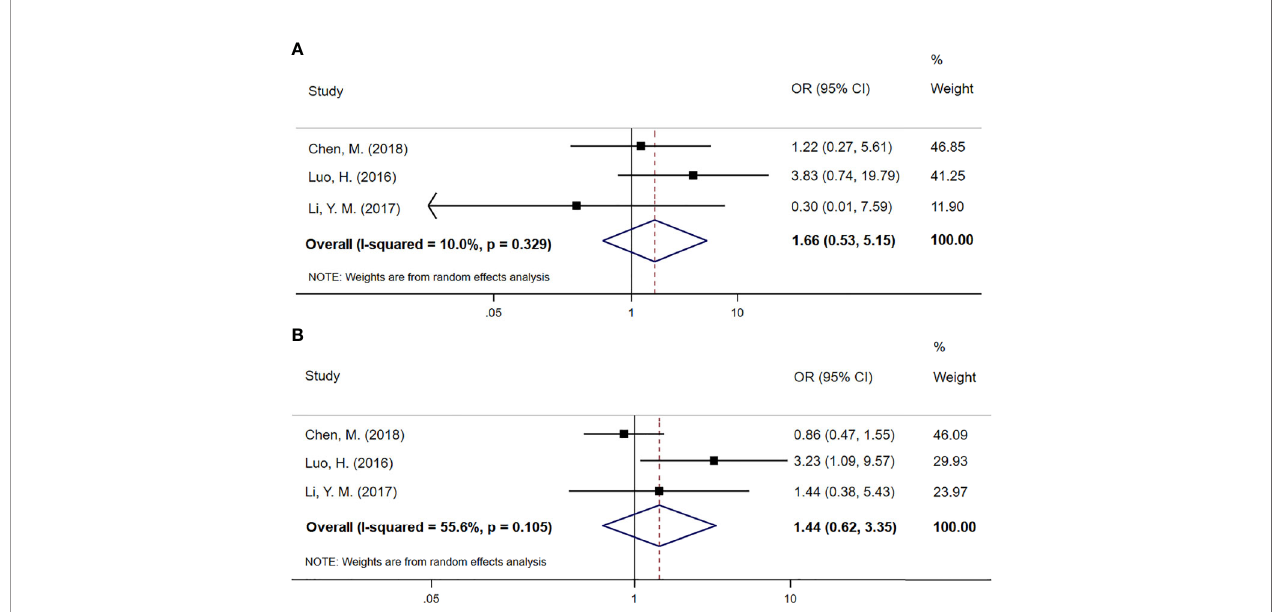
FIGURE 4 | (A) Meta-analysis of the associated ORs of DCR for CCRT – CCT compared with CCRT alone. (B) Meta-analysis of the associated ORs of ORR for CCRT – CCT compared with CCRT alone. OR, odds ratio; DCR, disease control rate; ORR, objective response rate; 95% CI, 95% con fi dence interval; CCRT – CCT, consolidation chemotherapy following concurrent chemoradiotherapy; CCRT alone, only concurrent chemoradiotherapy.